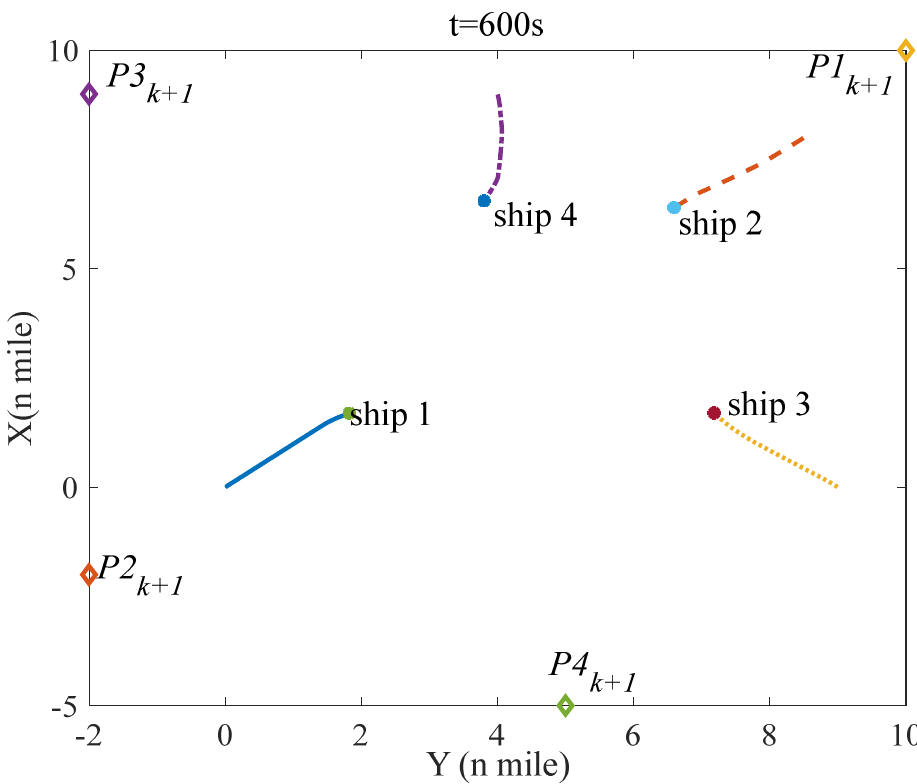
Figure 7. The situation of four ships at t = 600 s in scenario 1.